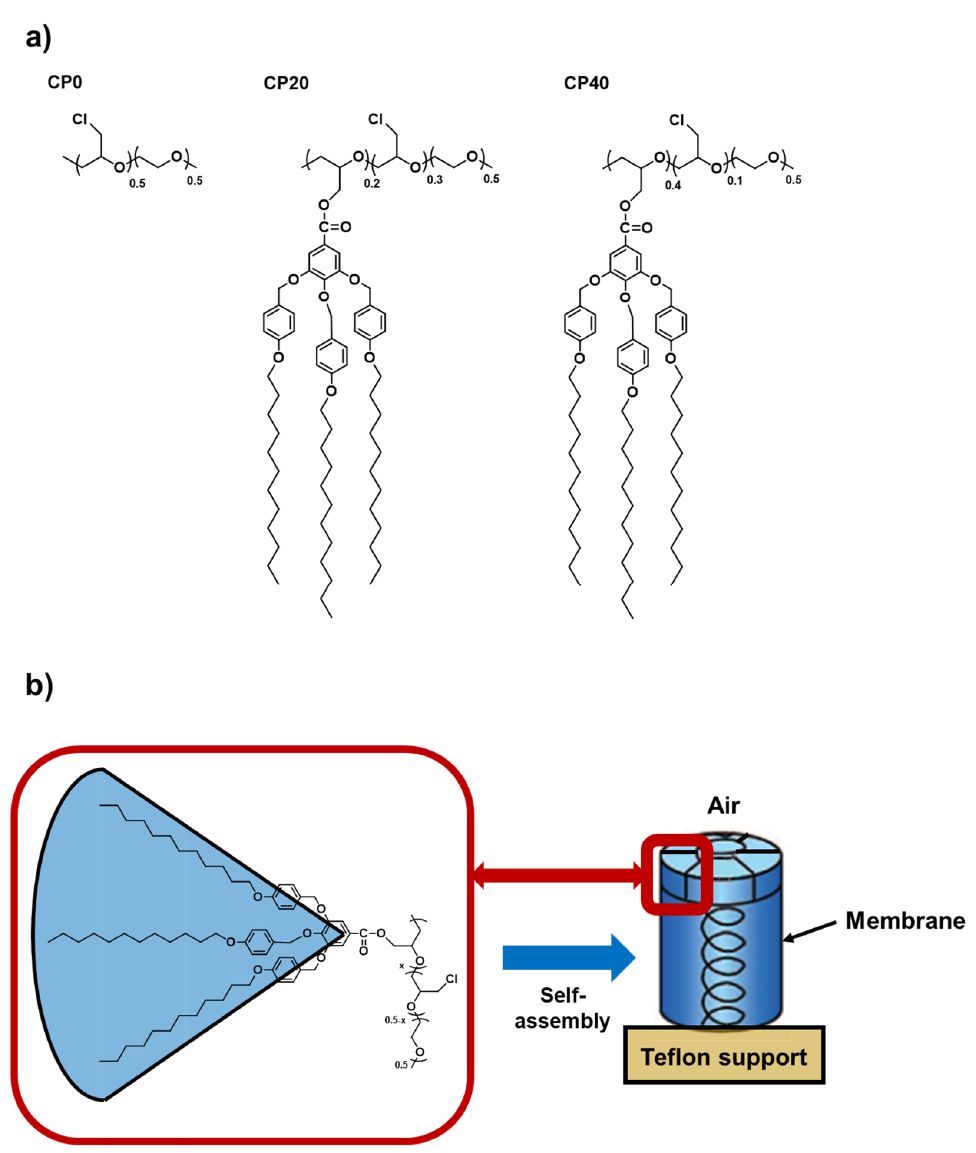
Figure 1. ( a ) Chemical structure of: CP0 (unmodified PECH-co-EO), CP20 (PECH-co-EO modified with 20% Tap dendron), and CP40 (PECH-co-EO modified with 40% Tap dendron). ( b ) Homeotropic alignment of the liquid-crystalline columns of the polymer to the membrane surface.